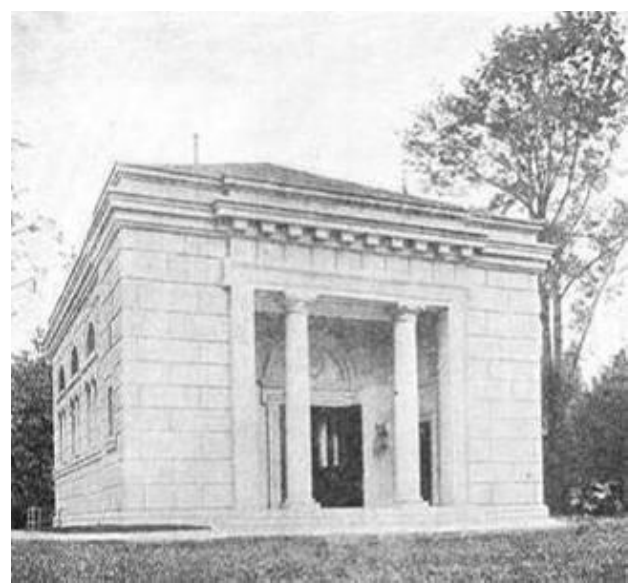
Figure 1. The Henry S. Frank Memorial Synagogue at the Jewish Hospital in Philadelphia, architect Arnold W. Brunner, 1901 (Adler and Rosenbach 1905, p. 678).